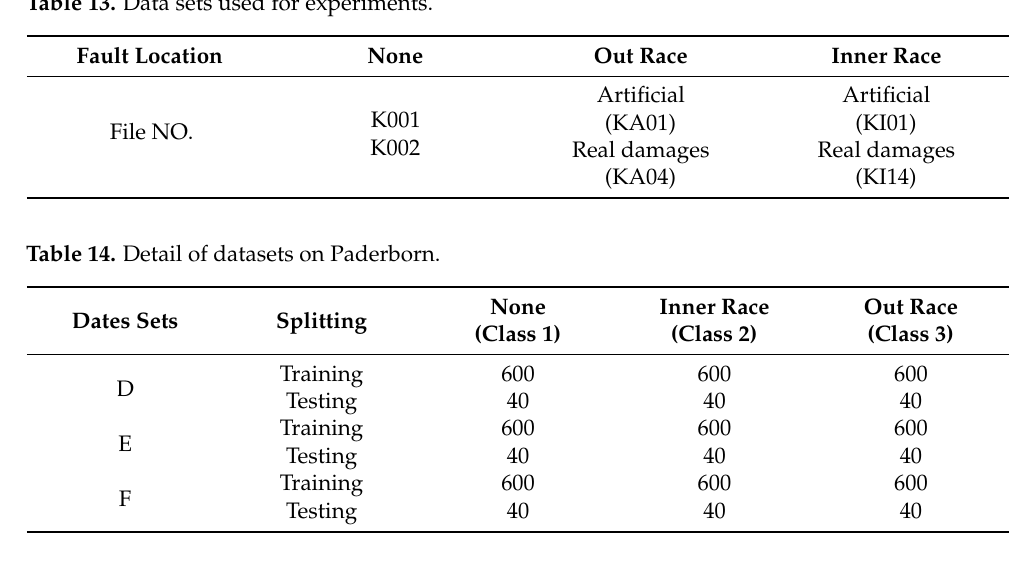
Table 13. Data sets used for experiments.